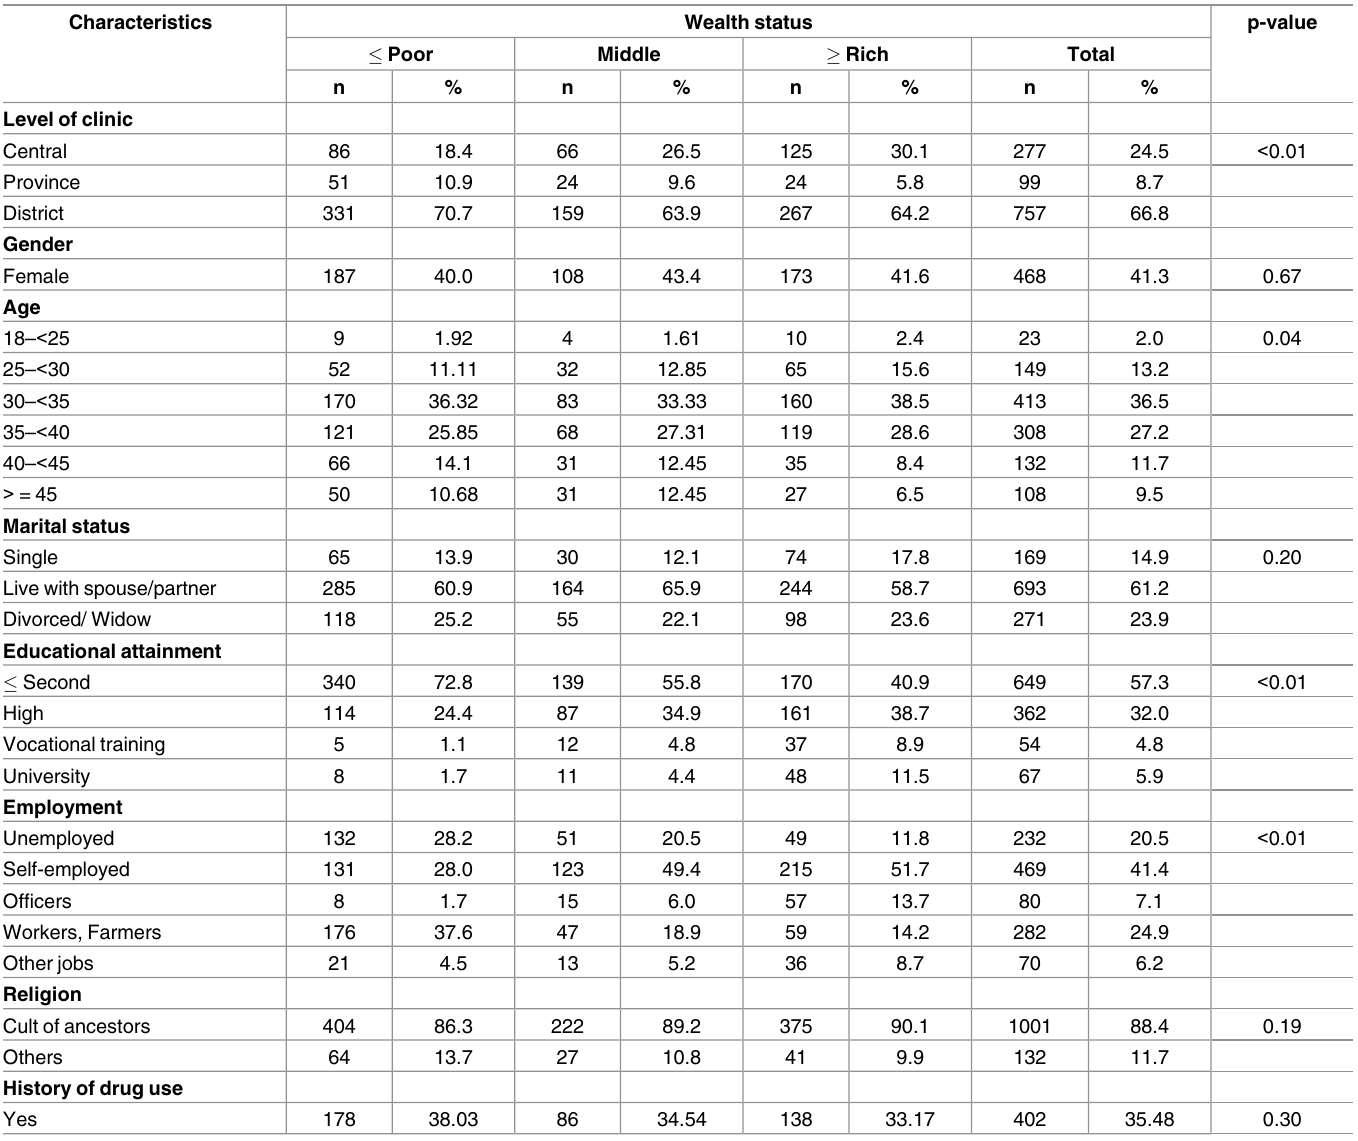
Table 1. Demographic characteristics of